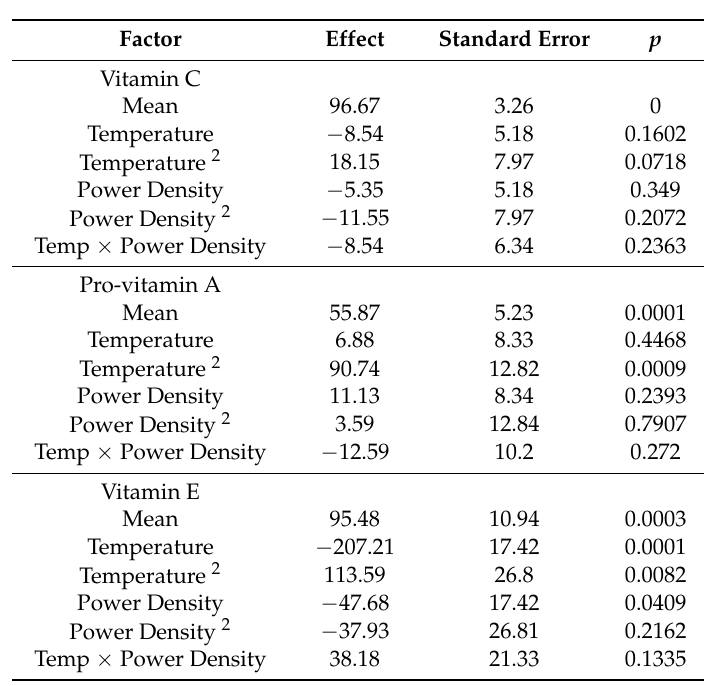
Figure 3. Influence of temperature, power density and processing time on the relative content of vitamins A ( a , b ) and E ( c , d ) in acerola juice. Table 3. Analysis of the perturbation of factors for vitamins C, pro-vitamin A and vitamin E in acerola juice subjected to ultrasound processing.